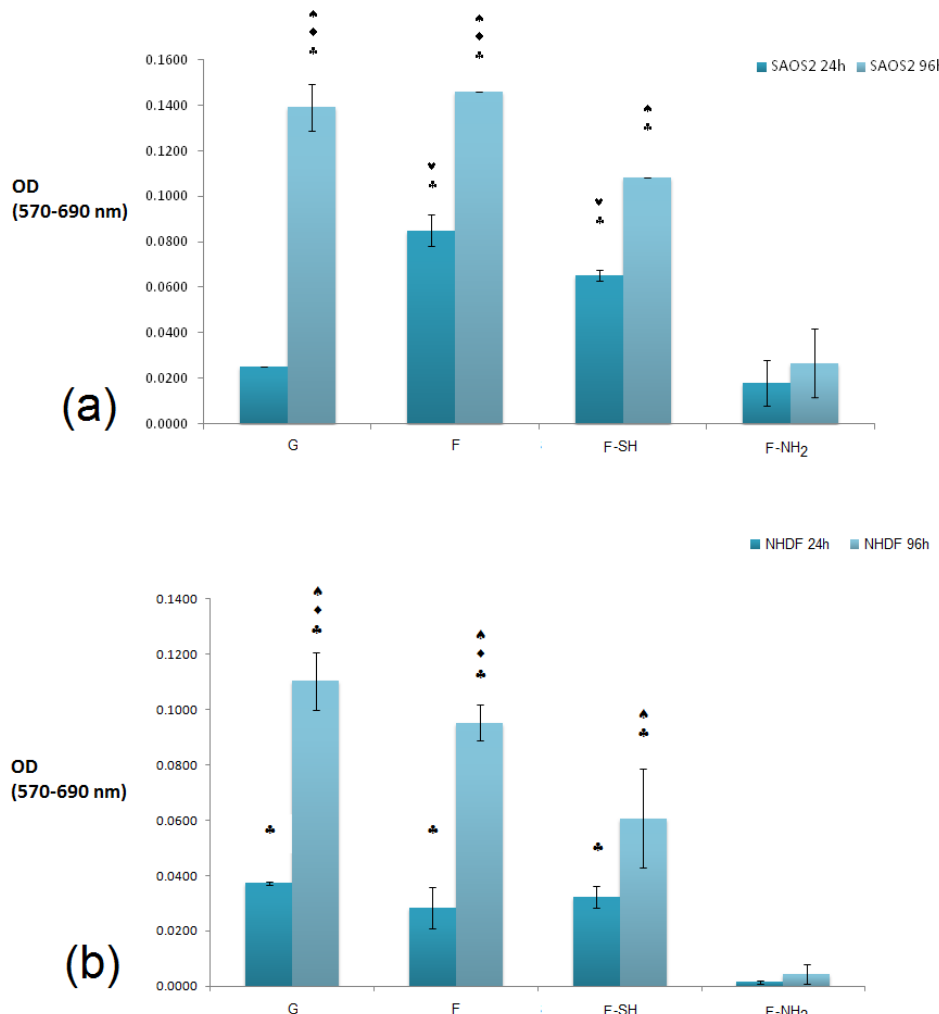
Figure 7. A comparison of viability values through optical densitis (OD, 570 nm-690 nm for background correction) of Saos-2. ( a ) normal human dermal fibroblasts (NHDF) ( b ) cell growth recorded at 24 and 96 h. The cells were grown on glass (G), functionalized (F–SH and F–NH 2 ) and native frustules (F) deposed on glass. Statistical differences among means were calculated by a two-way ANOVA test followed by a Bonferroni’s post-test: ♠ p < 0.01 vs 24h; ♥ p < 0.01 vs G; ♦ p < 0.01 vs F-SH; ♣ p < 0.01 vs F-NH 2 ; ✜ p < 0.01 vs F.